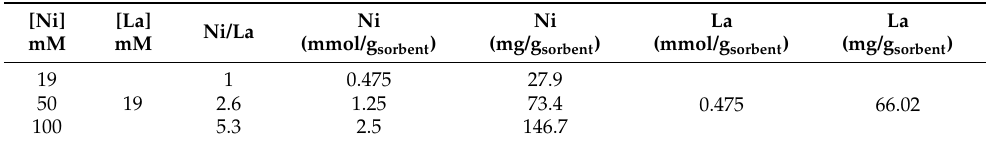
Table 2. Initial composition of the solutions applied in the capture experiments (average of 3 mea- surements estimated error from the replicate measurements is within